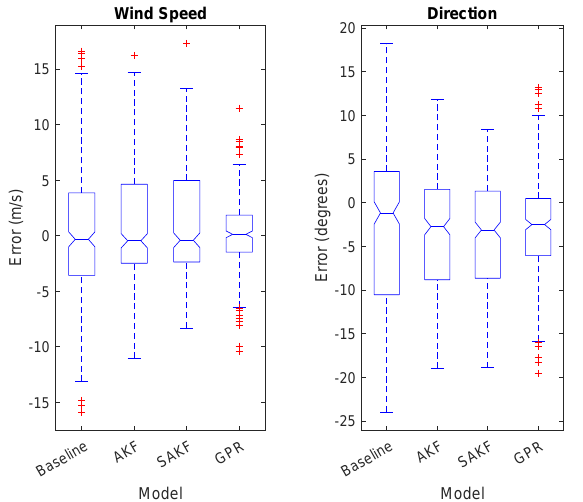
Figure 5. Wind speed and direction error boxplots for the different assimilation techniques.